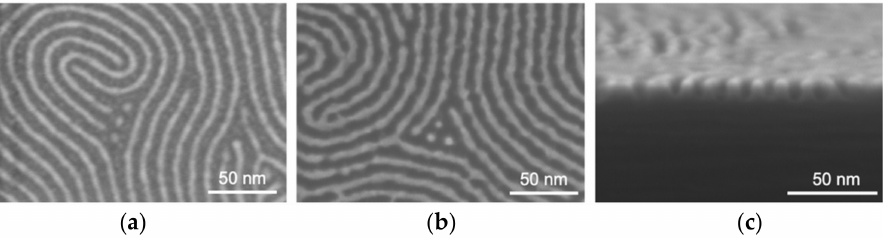
Figure 6. Pattern transfer of 12 nm pitch features. ( a ) scanning electron microscopy (SEM) top view image of a PS- b -MH layer on silicon after semi-static TMA/H 2 O infiltration and polymer removal, ( b ) SEM top view image of features etched into silicon, and ( c ) SEM cross-section image of features etched into